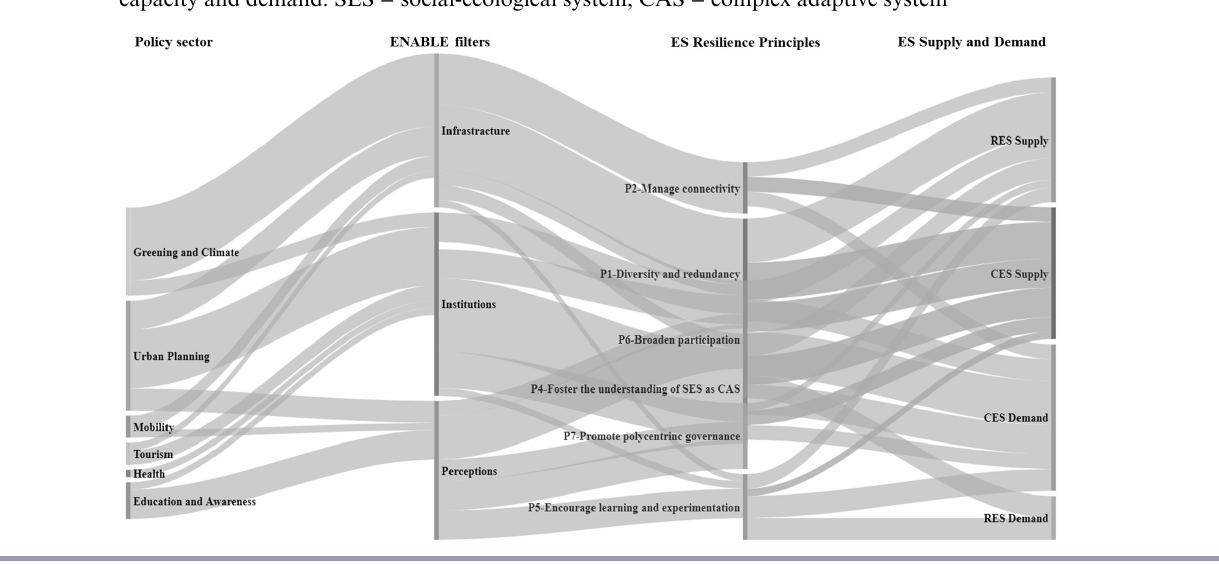
Fig. 4. Linkages between the identified policy clusters, the three filters (Andersson et al. 2019), the ecosystem services (ES) resilience principles (P1 to P7; Biggs et al. 2012), and the capacity and demand of cultural ES (CES) and regulating ES (RES). The thicker lines represent stronger relationships and provide insights into the enabling effects of diverse policy options on ES resilient capacity and demand. SES = social-ecological system; CAS = complex adaptive